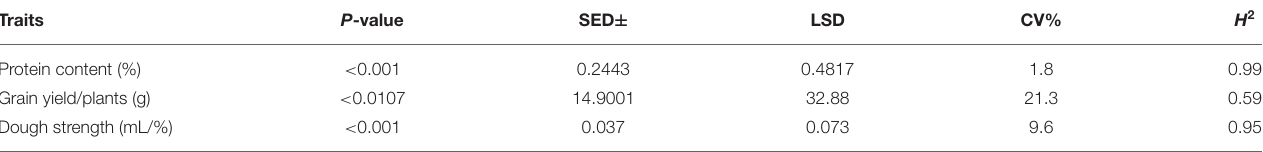
TABLE 3 | ANOVA and heritability for protein content (%), grain yield/plants (g), and dough strength (mL/%). Traits